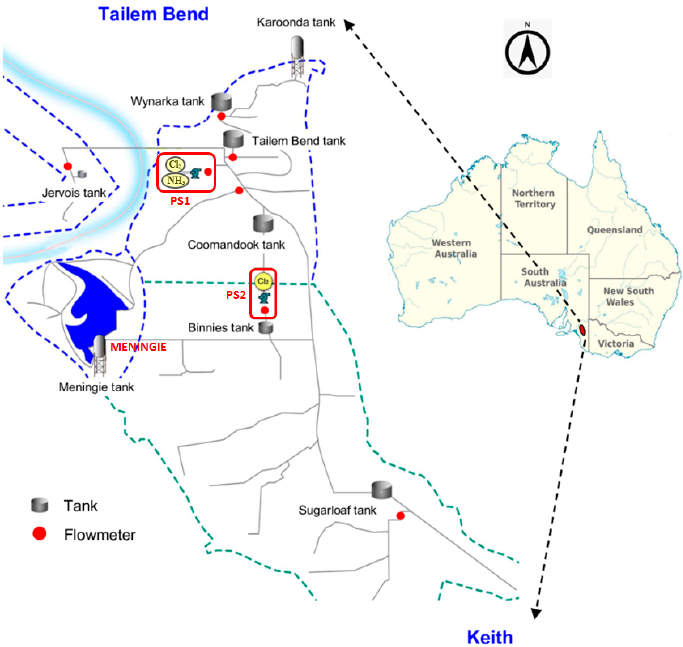
Figure 1. Schematic and location map of TBK drinking water distribution system.